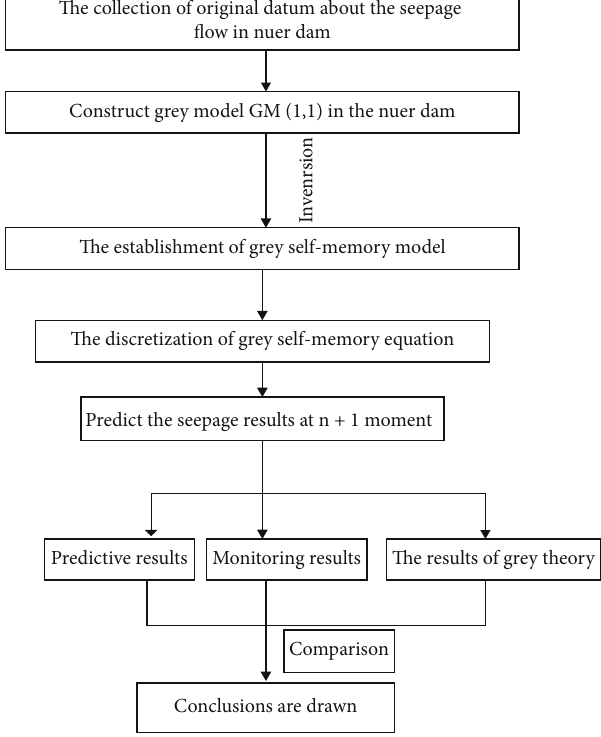
Figure 8. The calculative results are performed cumulative reduction because the backtracking and accumulative reduc- tion; only the monitoring datum in 17/8-10/12, 2018, is pre- dicted; their error results are shown in Table 1.